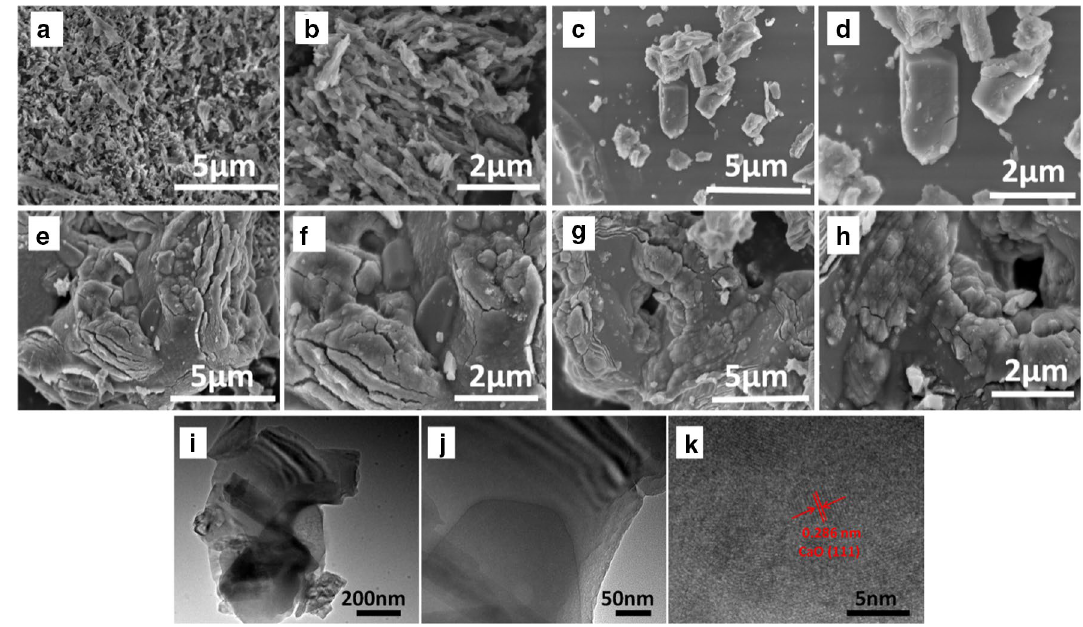
Figure 1. SEM images of clam shell samples: ( a , b ) uncalcined; ( c , d ) treated at 800 °C; ( e , f ) treated at 900 °C; ( g , h ) treated at 1000 °C; and TEM image ( i – k ) treated at 1000